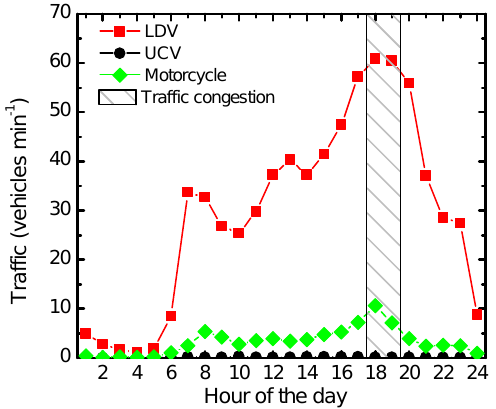
Fig. 2. Detailed view of the uncorrected and correct MAAP data from the JQ tunnel. Correction procedure performed according to Hyvärinen et al. (2013). Furthermore, measurements performed with light attenuation above 80% of reference (i.e. shortly after fil- ter spot change) were removed.